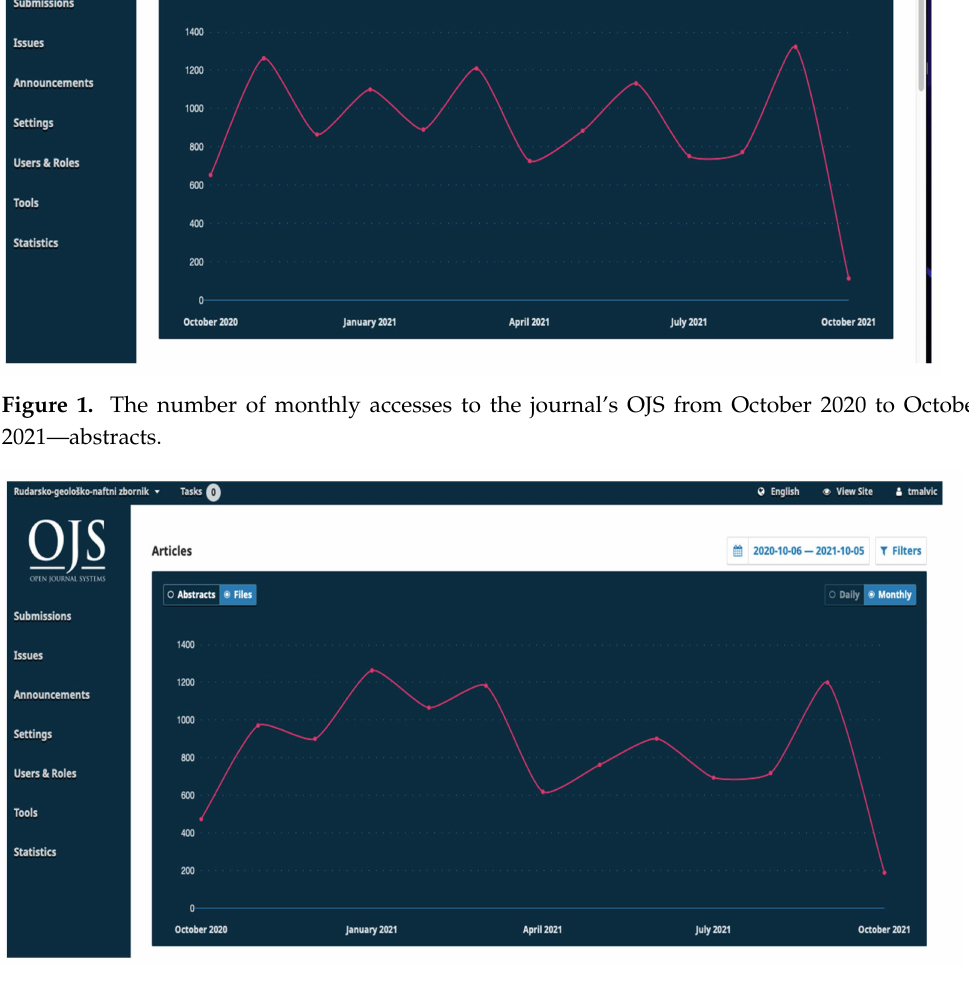
Figure 2. The number of monthly accesses to the journal’s OJS from October 2020 to October